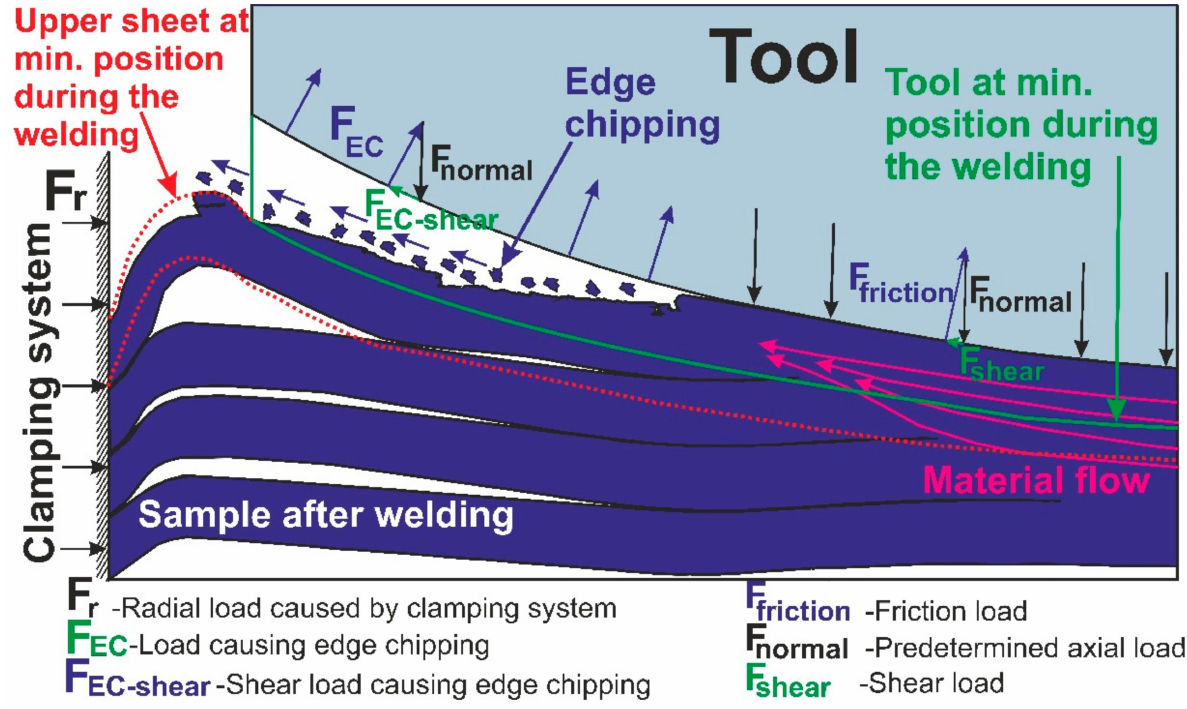
Figure 5. Schematic of the edge-chipping